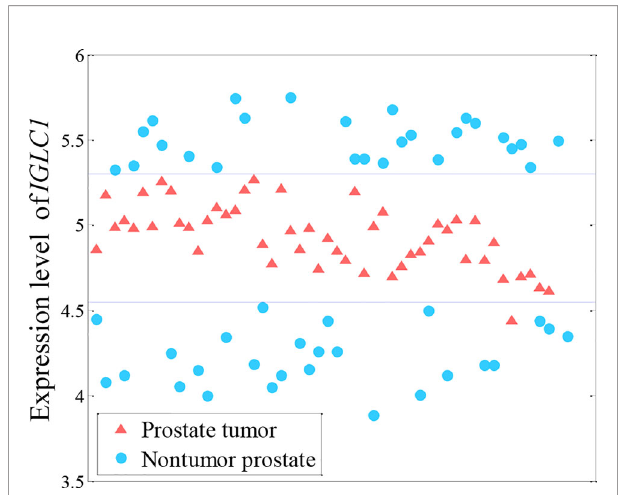
FIGURE 1 | Nonlinearly expressed pattern of the IGLC1 gene for prostate tumor from microarray data (Singh et al., 2002). Both high and low levels of IGLC1 gene expression are found in non-tumor samples.